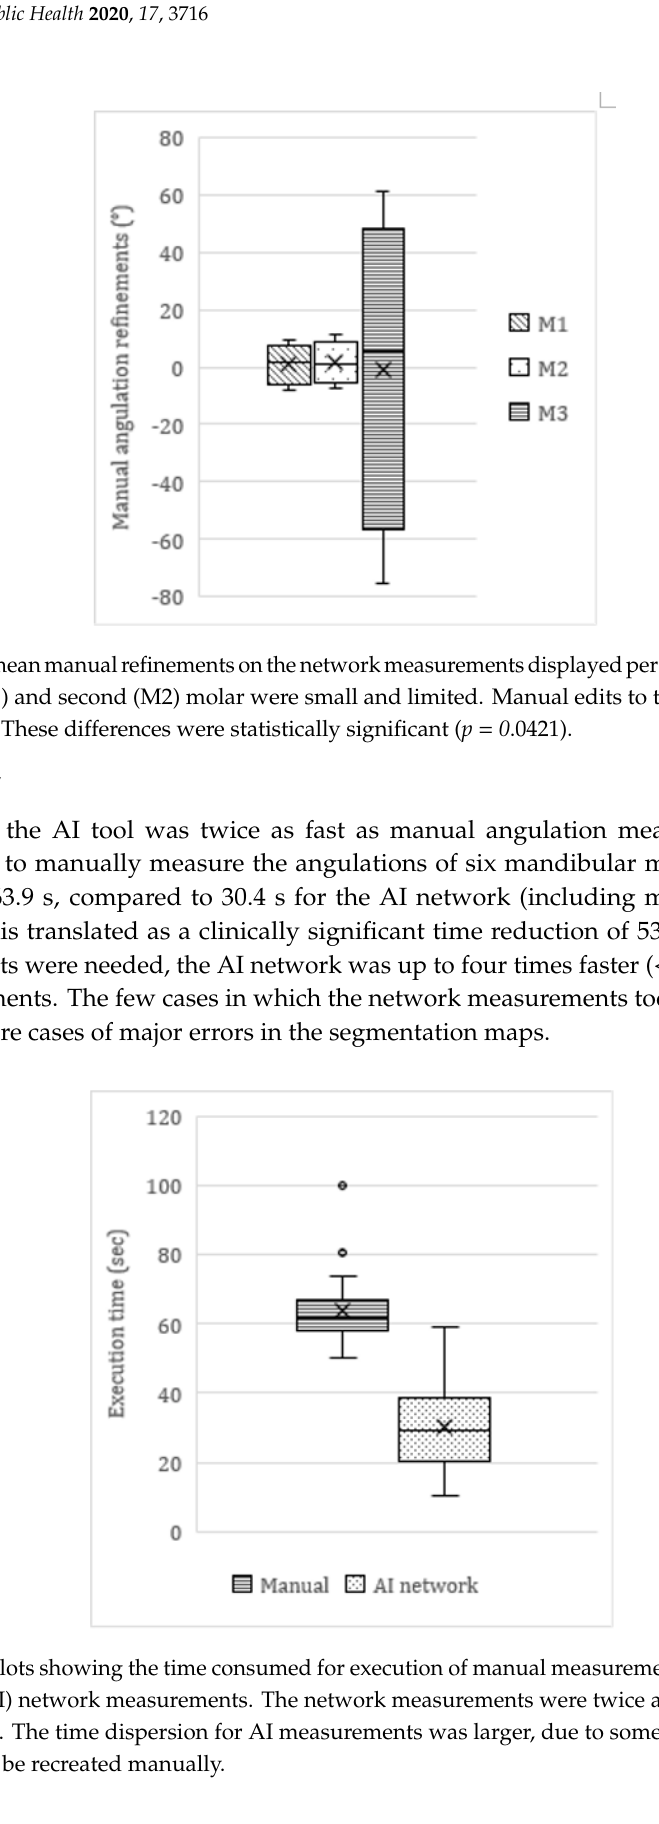
Figure 6. Boxplots showing the time consumed for execution of manual measurements vs. the Artificial Intelligence (AI) network measurements. The network measurements were twice as fast as the manual measurements. The time dispersion for AI measurements was larger, due to some mis-segmentations that needed to be recreated